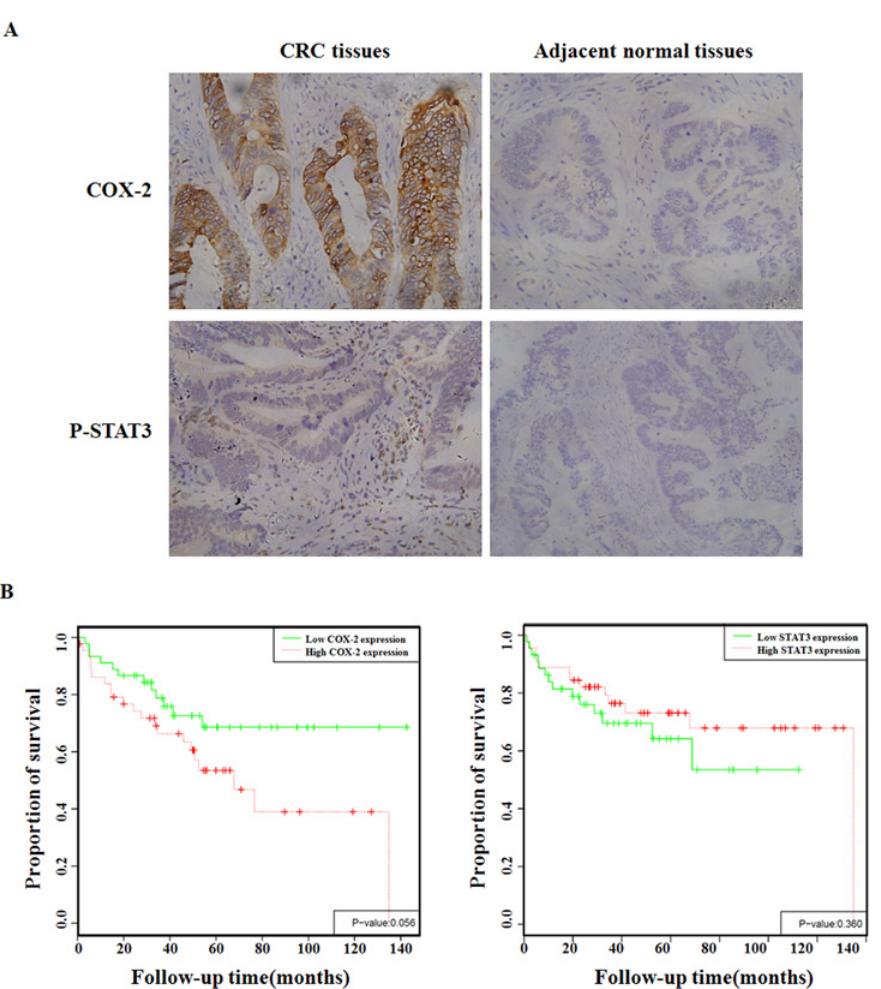
Fig 4. Expression levels of COX-2 and pSTAT3 are higher in primary CRC. A. Examples of CRC tumor specimens stained for COX-2 and pSTAT3 are shown. B. Expression levels of COX-2 and pSTAT3 don ’ t correlate with CRC patients ’ survival.